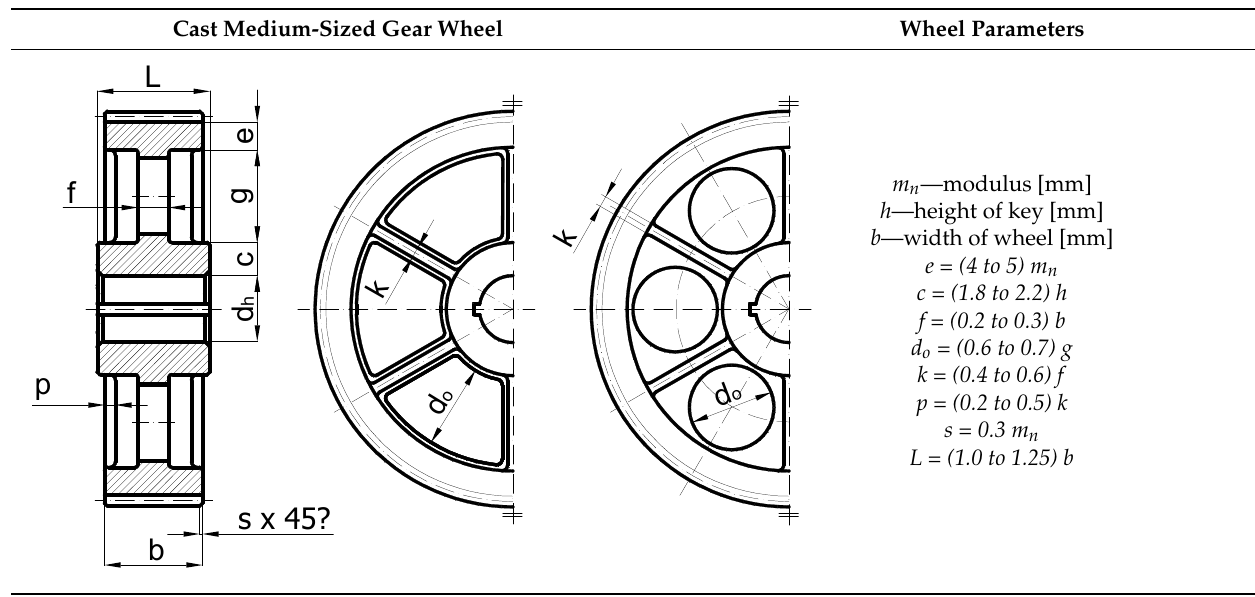
Table 3. Cast medium-sized spur gear: basic geometric parameters.